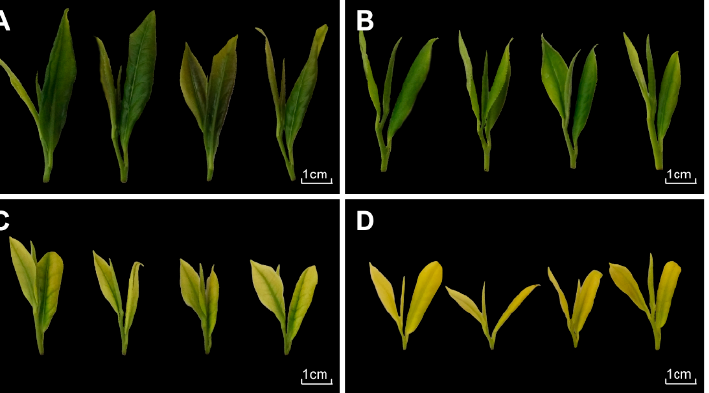
Figure 7. Leaf phenotypes of four tea cultivars used in this study. ( A ) ‘Huangjincha2’ (HJC2); ( B ) ‘Baojing Huangjincha1’ (BJ1); ( C ) ‘Baiye1’ (BY1); ( D ) ‘Huangjinya’ (HJY). Tea leaves were collected based on the “one bud and two leaves” standard. Bars, 1 cm.